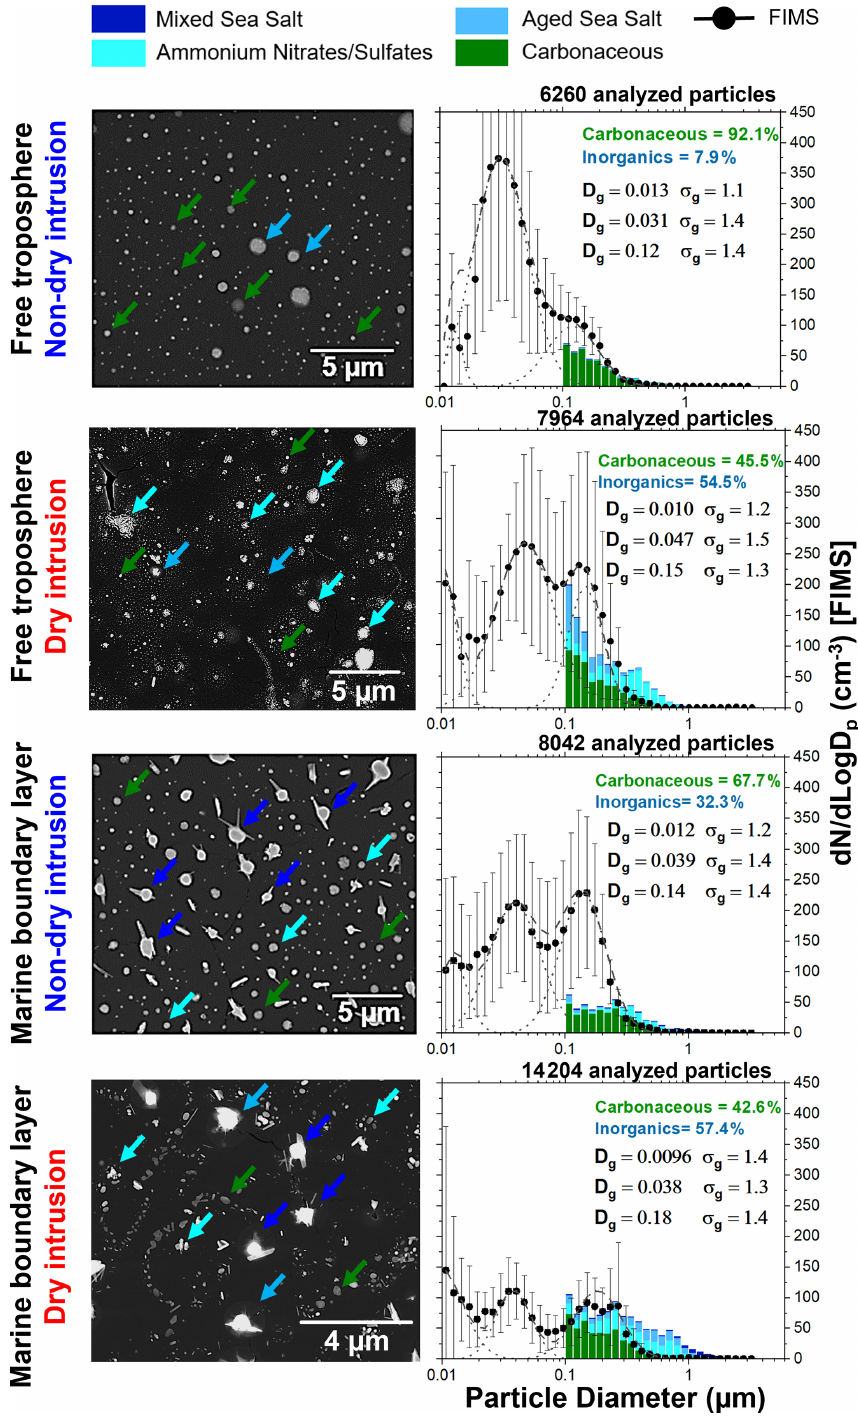
Figure 2. Representative backscattering-mode SEM imaging of particles (left column) and relative particle-type populations (right column) determined by CCSEM/EDX and k -means clustering analysis, summarized as a 16-bin per decade histogram representative of MBL and FT atmospheric layers and DI versus non-DI synoptic conditions. The compositions of the size-segregated particle-type population were broken down into carbonaceous and inorganics (i.e., mixed sea salt + aged sea salt + ammonium nitrate–sulfate). The average FIMS aerosol size distribution measured on board G1 is superimposed and anchored at 0.25µm to facilitate a visual assessment of particle types and number concentrations for CCN active particles ( > 100nm). Lognormal-mode diameter ( D g ) and standard deviation ( σ g ) were fitted for the FIMS particle size distribution (gray dashed